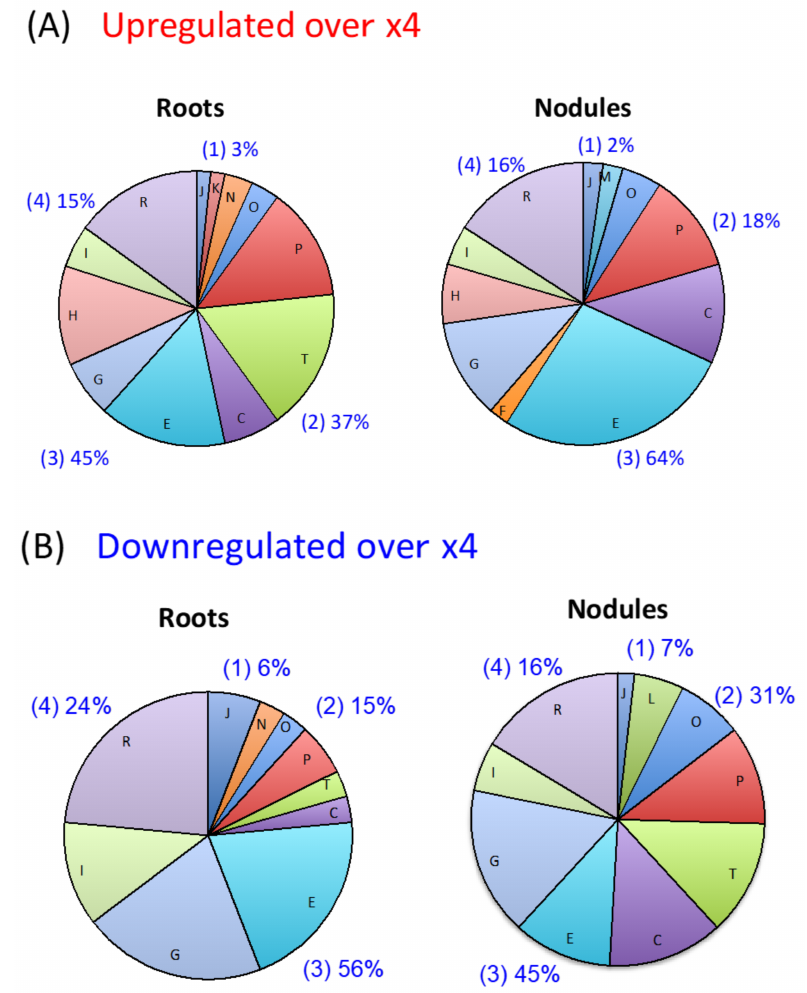
Figure 2. Functional distribution of genes differentially expressed in soybean roots and nodules by the 5-mM nitrate treatment. ( A ) Upregulated genes > fourfold in the roots and nodules of soybean plants after 24 h of the 5 mM of the nitrate treatment compared with control. ( B ) Downergulated genes > fourfold in the roots and nodules of soybean plants after 24 h of the 5 mM of the nitrate treatment compared with control. Functional categories: (1) Information storage and processing, J: translation, ribosomal structure and biogenesis, K: transcription, L: DNA replication, recombination, and repair. (2) Cellular processes, D: cell division and chromosome partitioning, M: cell envelope biogenesis, outer membrane, N: cell motility and secretion, O: post-translational modification, protein turnover, chaperones, P: inorganic ion transport and metabolism, T: signal transduction mechanisms. (3) Metabolism, C: energy production and conversion, E: amino acid transport and metabolism, F: nucleotide transport and metabolism, G: carbohydrate transport and metabolism, H: coenzyme transport and metabolism, I: lipid metabolism. (4) Poorly characterized proteins, R: general function prediction